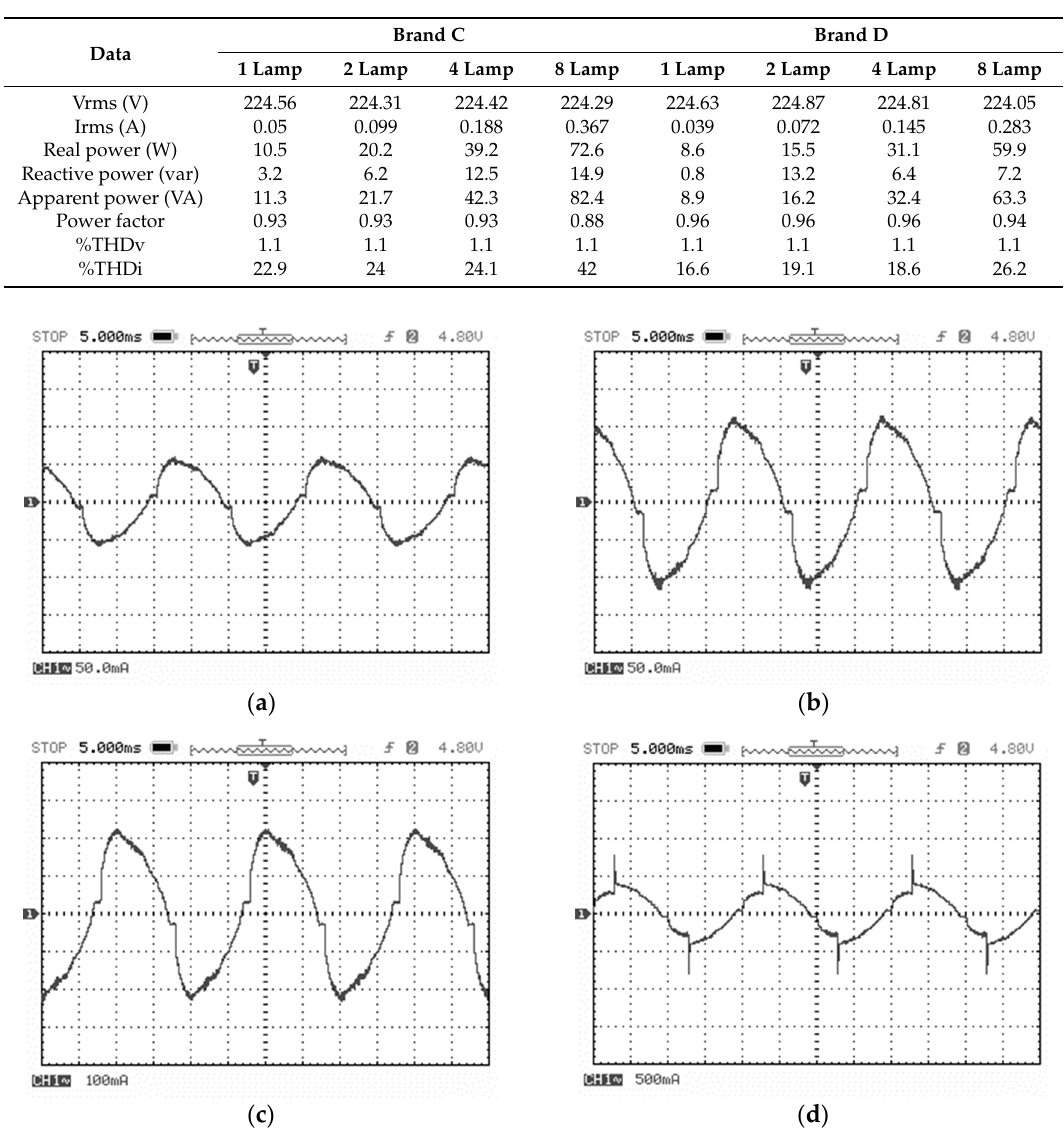
Figure 10. Waveform of LED lamp for brand C. ( a ) Current waveform in the case of one lamp; ( b ) Current waveform in the case of two lamps; ( c ) Current waveform in the case of four lamps; ( d ) Current waveform in the case of eight lamps.